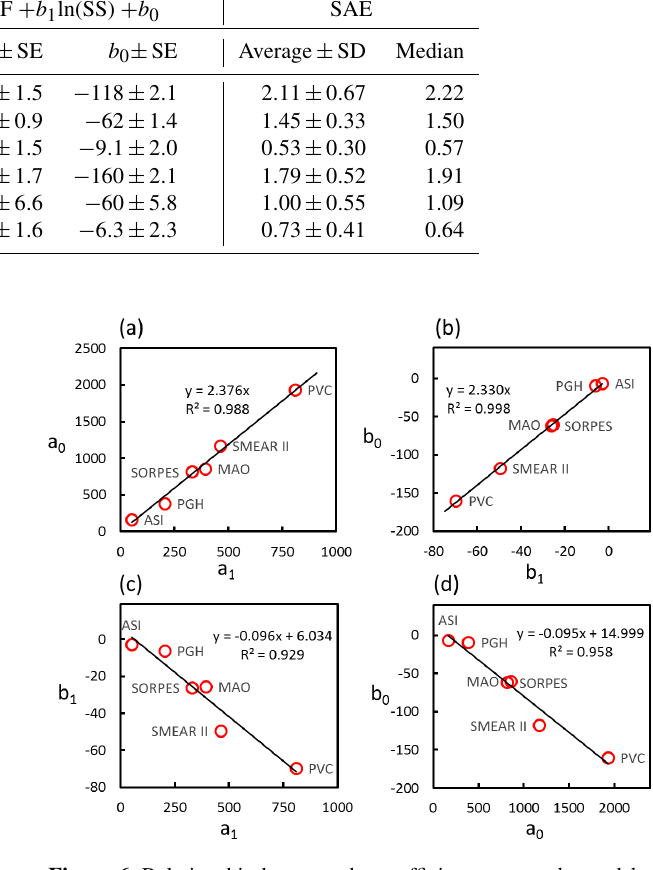
Figure 6. Relationship between the coefficients a 0 , a 1 , b 0 , and b 1 of Eq. (7) for each station presented in Table 4 for the six